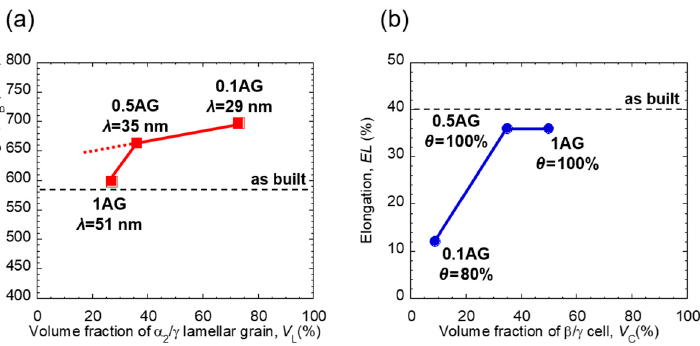
Figure 10. Variations in σ B ( a ) and EL ( b ) of the aged rods at 1023 K as a function of V L and V C , respectively.